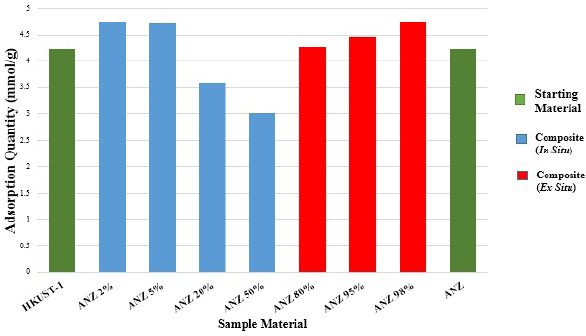
adsorption capacity of HKUST-1, ANZ, and the Figure 6 : The CO 2 composite ANZ@ HKUST-1.